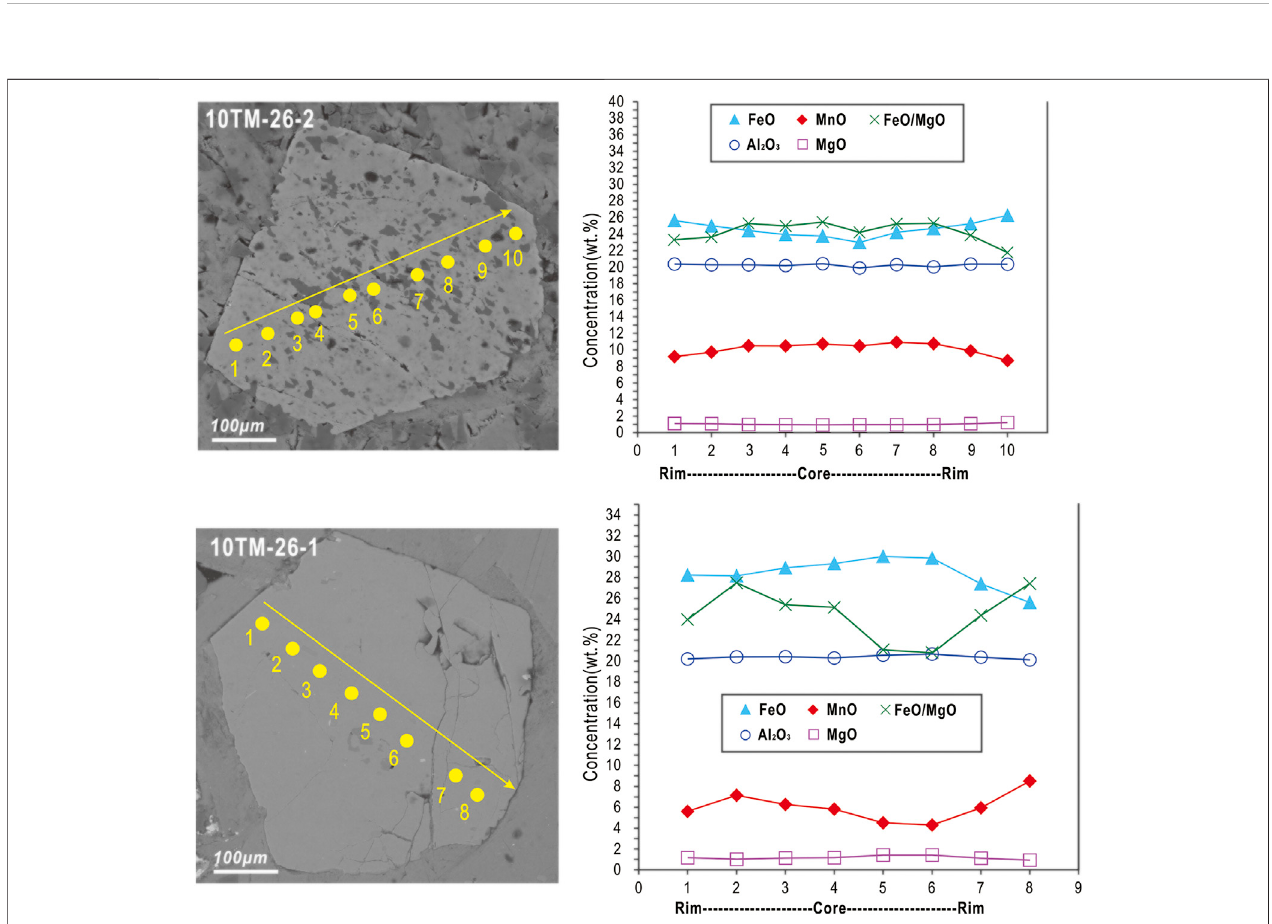
FIGURE 5 | Backscattered electron (BSE) imaging coupled with EPMA analysis on major elements pro fi les for Grt1 (10TM-26-2 and 10TM-26-1).